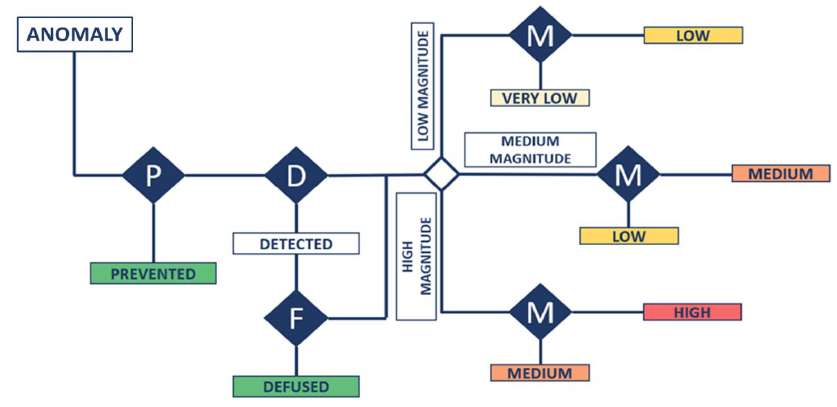
Figure 4. Possible Outcomes of Countermeasure Application.